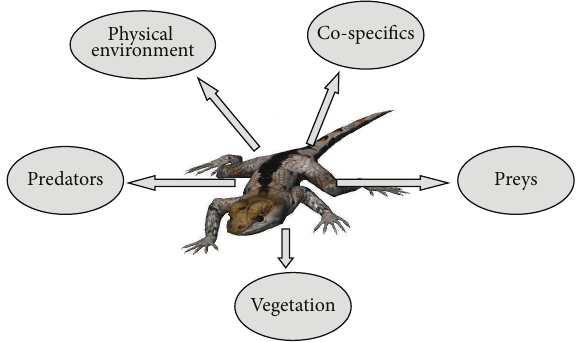
Figure 2: Ecological relationships modeled in the game.